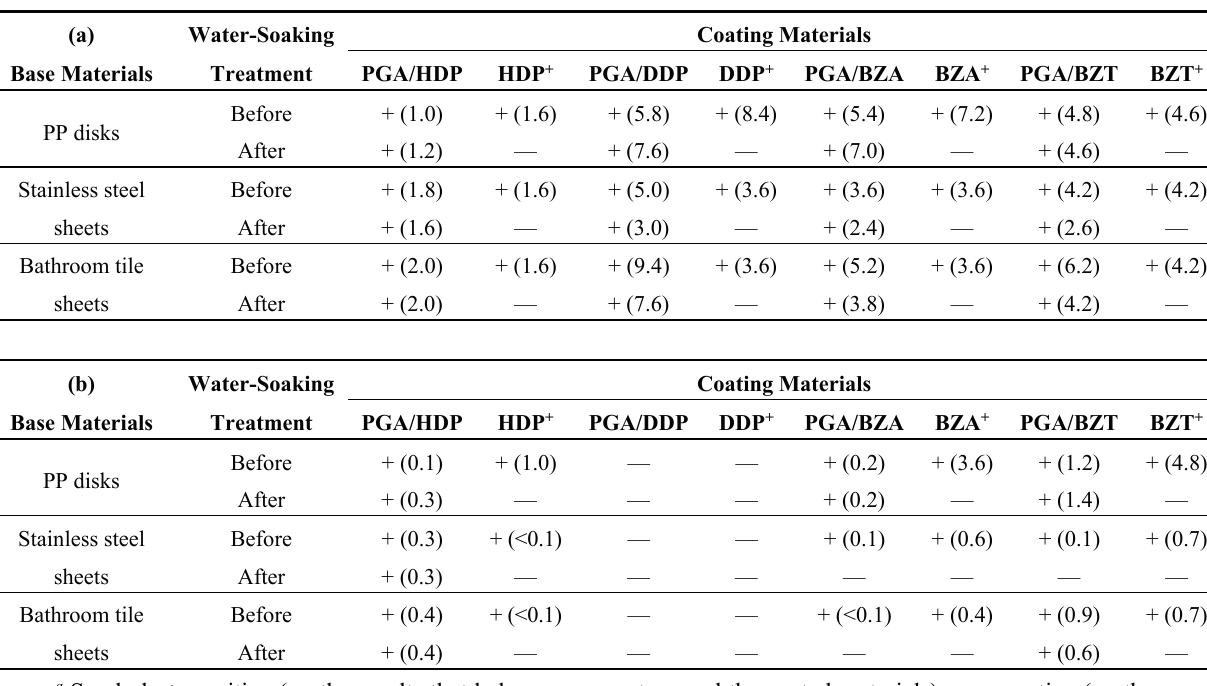
Table 1. Halo assays for determination of ( a ) anti-staphylococcal and ( b ) anti-Candida activities of PGAIC-coated materials a , b .